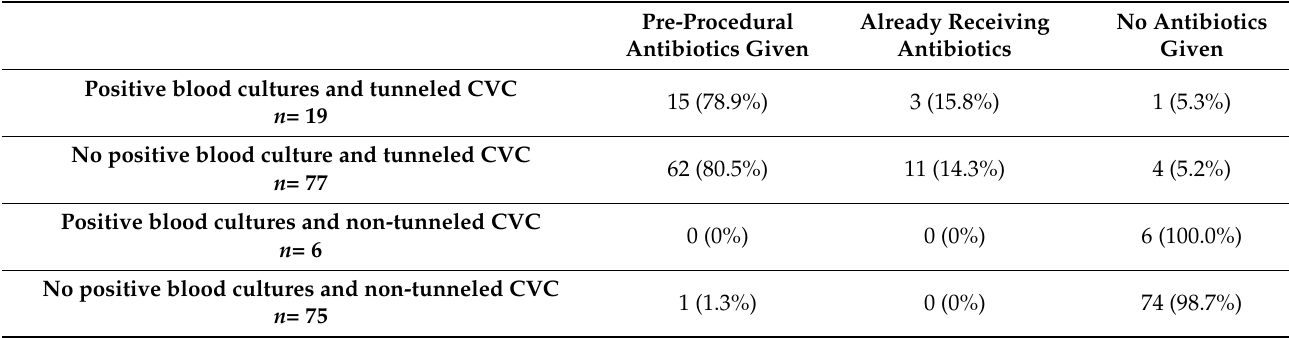
Table 2. Antibiotics at time of CVC placement.